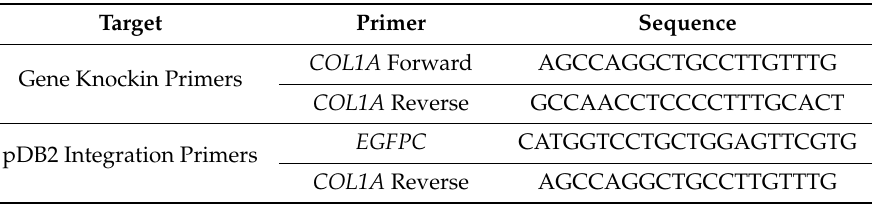
Table 2. Primers used in the